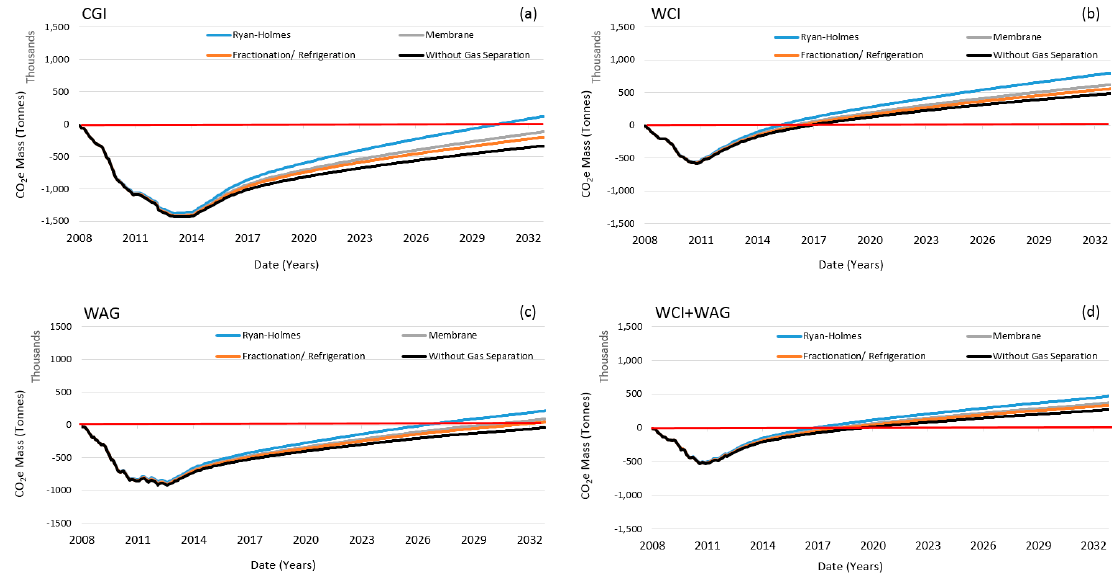
Figure 9. Carbon balance (CO 2 e emissions minus CO 2 storage) of the gate-to-grave CCUS system with stacked saline carbon storage. ( a ) continuous gas injection, ( b ) water curtain injection, ( c ) water-alternating-gas, and ( d ) the hybrid scenario. Table 4. Important CCUS parameters at the transition point (CO 2 storage = CO 2 e emissions). Scenarios with stacked saline carbon storage.